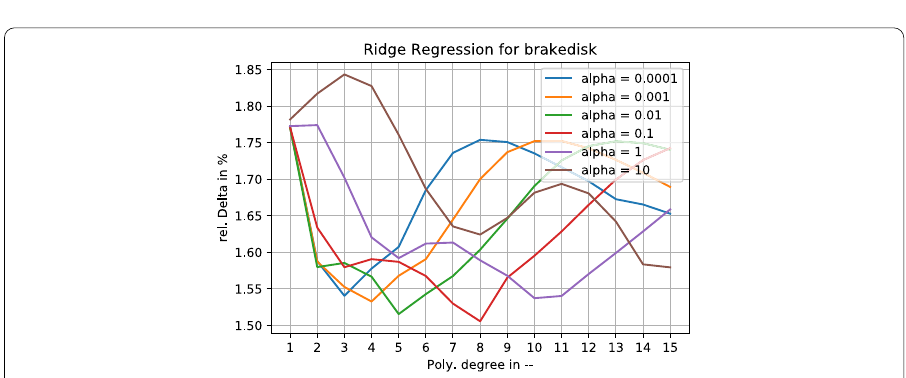
Fig. 16 Brakedisk with ridge comparison evaluation of ridge-regression-performance of (cid:2) rel for n poly and α -variation for the